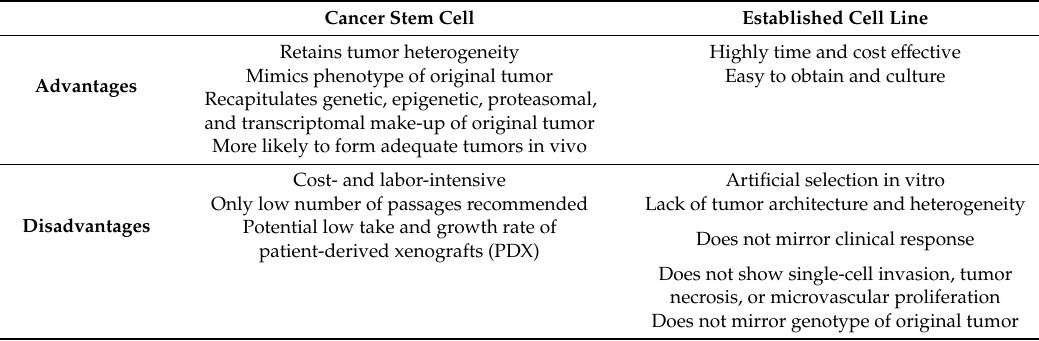
Table 1. Cancer stem cell cultures compared to established cell line